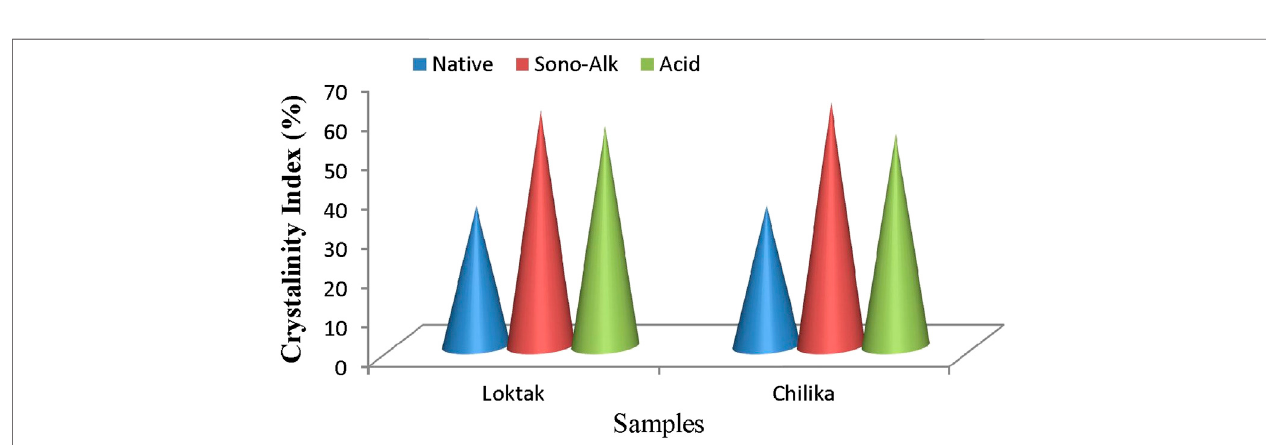
FIGURE 3 | Crystalinity index (%) of pretreated biomass of tall reed grass.